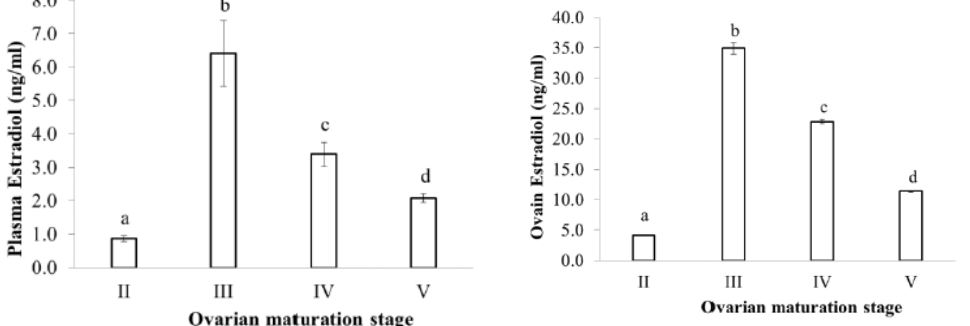
Figure 3. Estradiol level at different ovarian maturation stages of the blue tang fish (n the same as Figure 2b; data with a different subscript letter (a, b, etc.) are significantly different at p = 0.05).